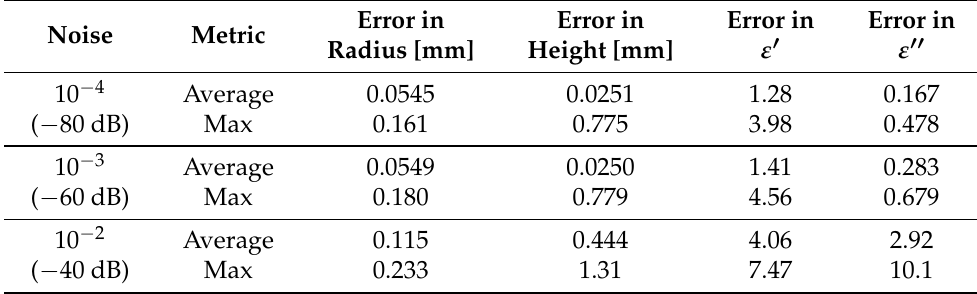
Table 4. Summary of error in predictions for the noisy, tumor-containing test cases.